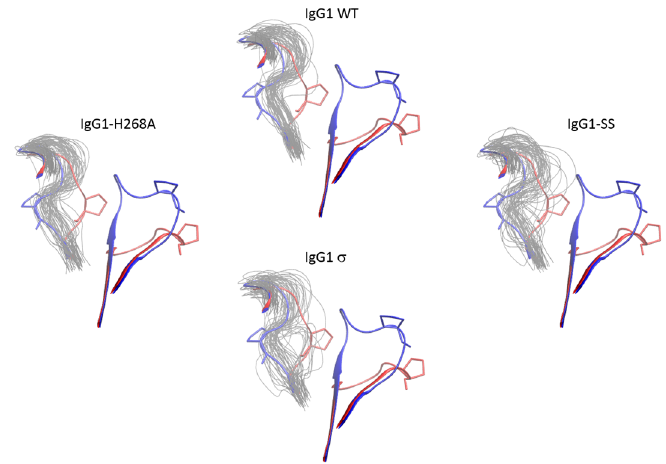
Figure 16. Conformational distribution of the BC loop of chain B of C H 2 domain from molecular dynamics simulations of huIgG1 wild ‐ type and mutants. Each panel shows the flipped ‐ in (blue cartoon) and flipped ‐ out (red cartoon) conformations of the two loops. The flipped ‐ in conformation is from the huIgG1 WT (PDB 3AVE [40]) while the flipped ‐ out conformation is from huIgG4 WT (PDB 4C54 [50]). The huIgG1 σ was started with the BC loop in the flipped ‐ out conformation while the other simulations started from the flipped ‐ in conformation. The panels show fifty conformations (gray) sampled at an interval of 2 ns after aligning the MD trajectory on the C α atoms of the non ‐ BC and non ‐ FG residues of the C H 2 domain of chain B in the corresponding crystal structure. Figure S5 shows the conformation of P271 in the above loop conformations. In the wild ‐ type and huIgG1 ‐ H268A simulations, the BC loop remained close to the initial flipped ‐ in conformation of the loop. The huIgG1 σ showed a broader distribution around the flipped ‐ in state while huIgG1 σ samples both flipped ‐ in and flipped ‐ out states though the flipped ‐ in state was dominant.